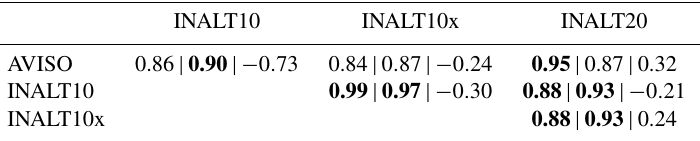
Table 5. Correlations in SSH variance time series (yearly) (see Fig. 5) between AVISO and the nested configurations as well as among the nested configurations for the period 1995–2005 for the three regions indicated in Fig. 3f: southwest of Madagascar (SOM) | Agulhas retroflection (AR) | Cape Basin (CB). Significant correlations (at 95% confidence level) are given in